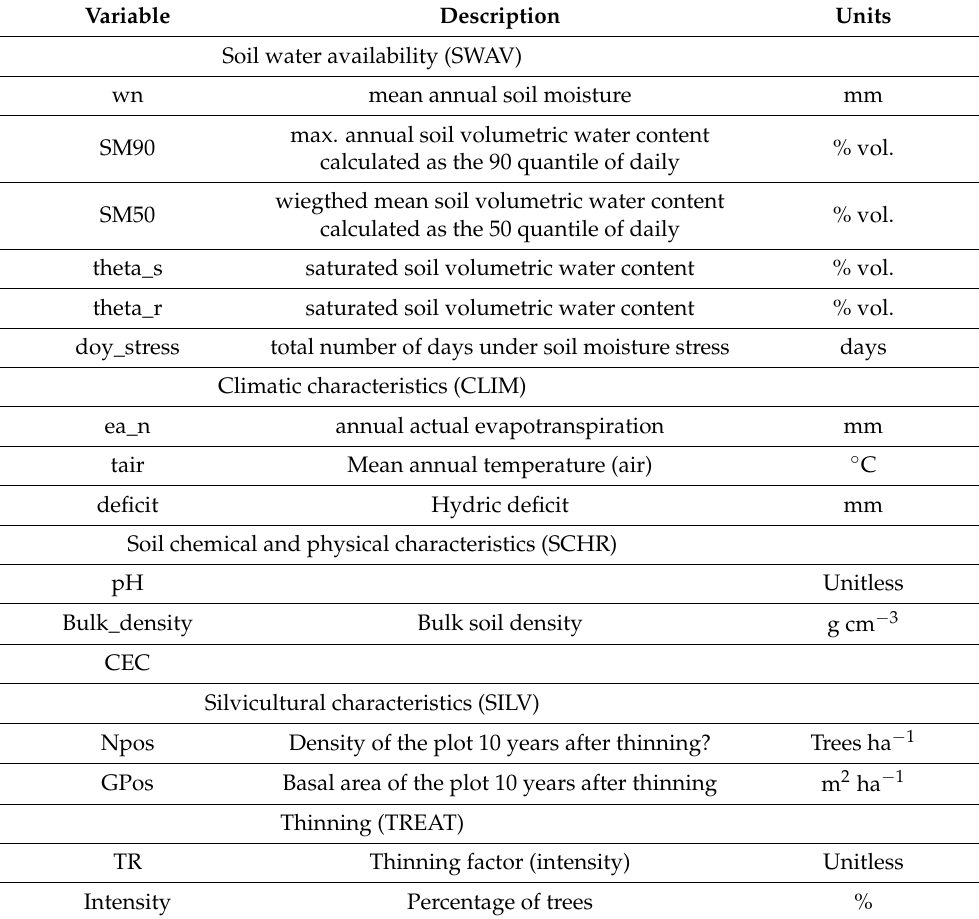
Table 2. Environmental data used to predict the effect of thinning on soil C sequestration (SOC 10 ) after the PCA selection for the construction of latent